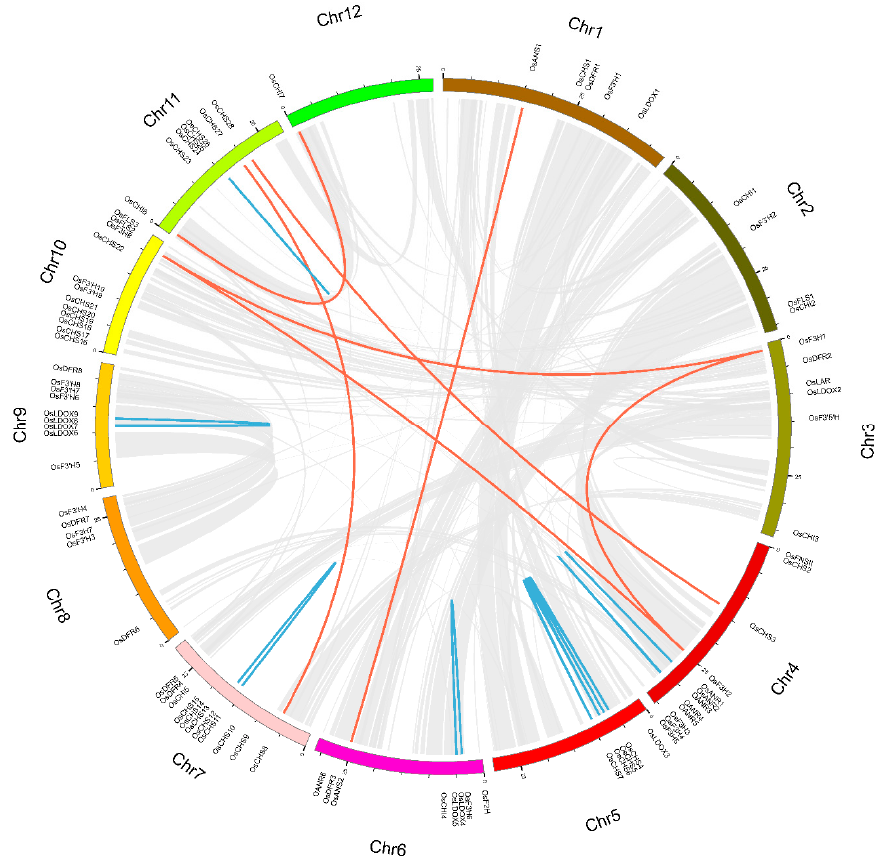
Figure 3. Chromosome location and duplication events of 85 genes associated with the rice flavonoid scaffold biosynthesis pathway in rice: 12 different chromosomes are displayed with 12 distinct colors. The segmental duplication and tandem duplication events are shown with red and blue lines, respectively, via Circos software.